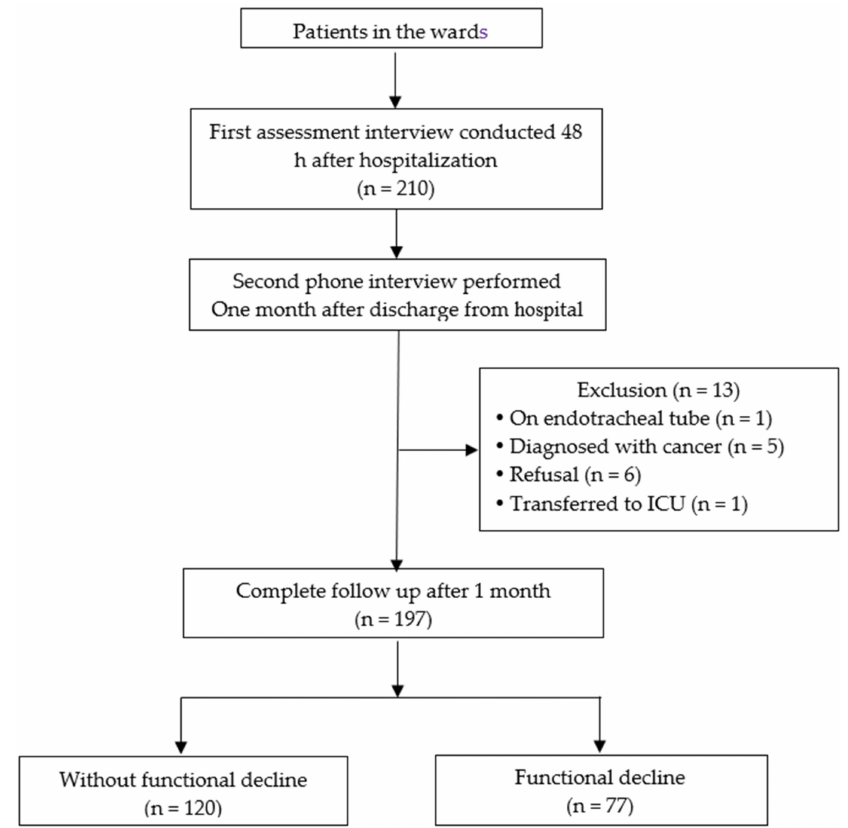
Figure 1. Flow chart of patient